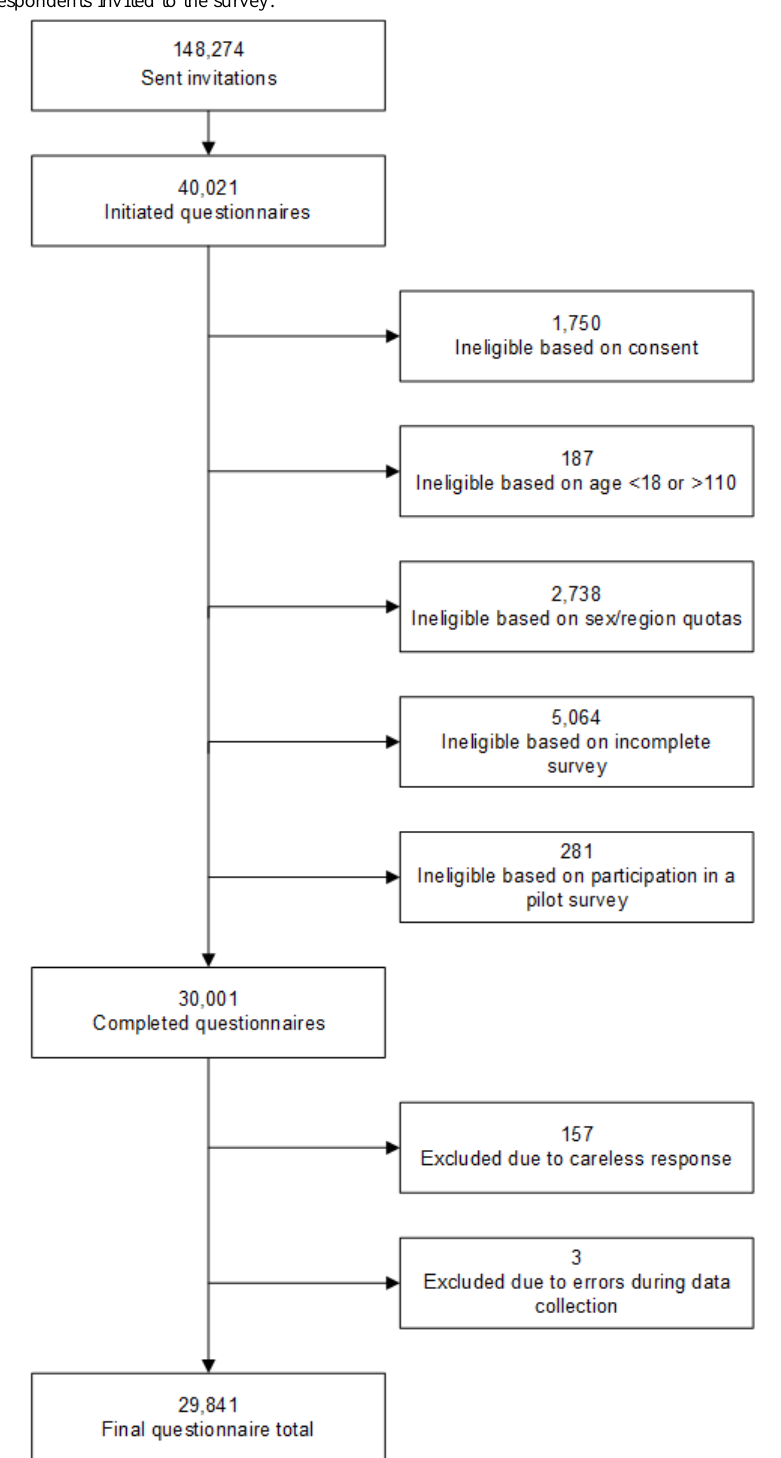
Figure 3. Flow diagram of respondents invited to the